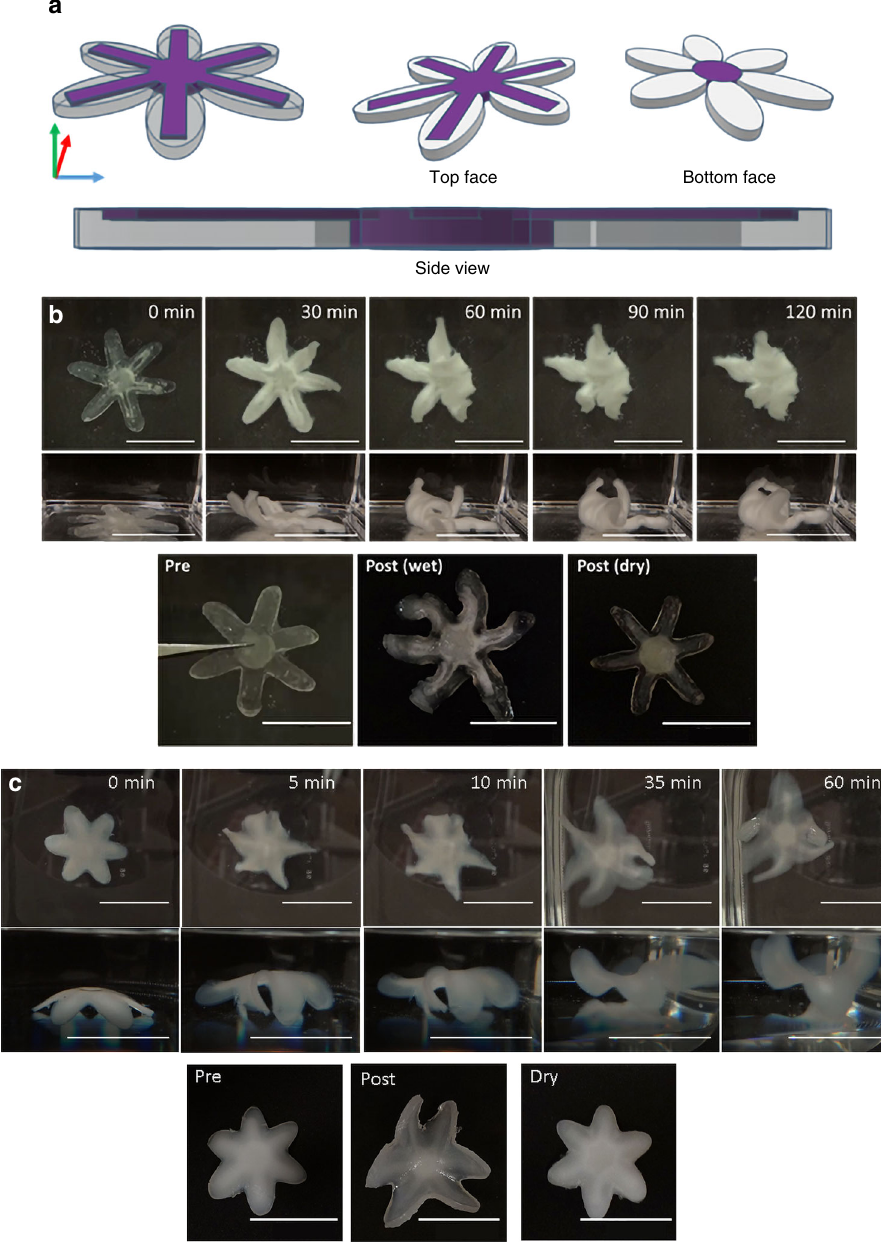
Fig. 5 Time-lapse photos of swelling induced actuation in printed sea stars. a CAD models of multimaterial sea star. Tip-to-tip length = 38 mm, core diameter = 9 mm, inlaid beams within each arm = 13 mm. Purple corresponds to UV irradiation and white/transparent corresponds to visible light irradiation. b Swelling results of a sea star in water printed using the HEA-1 MASC formulation. Scale bars = 25 mm. c Swelling results of a sea star in toluene printed using the BA-1 MASC formulation. Scale bars = 25